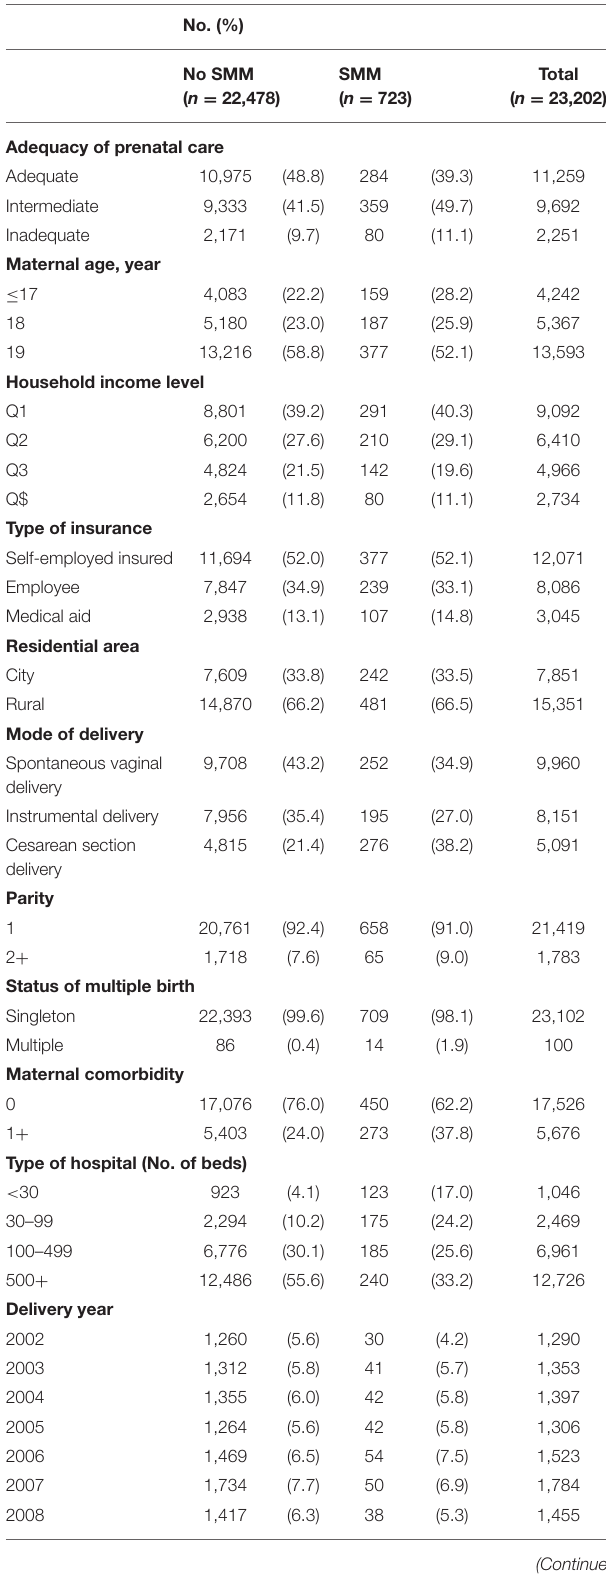
TABLE 1 | Baseline characteristics of study population with and without severe maternal